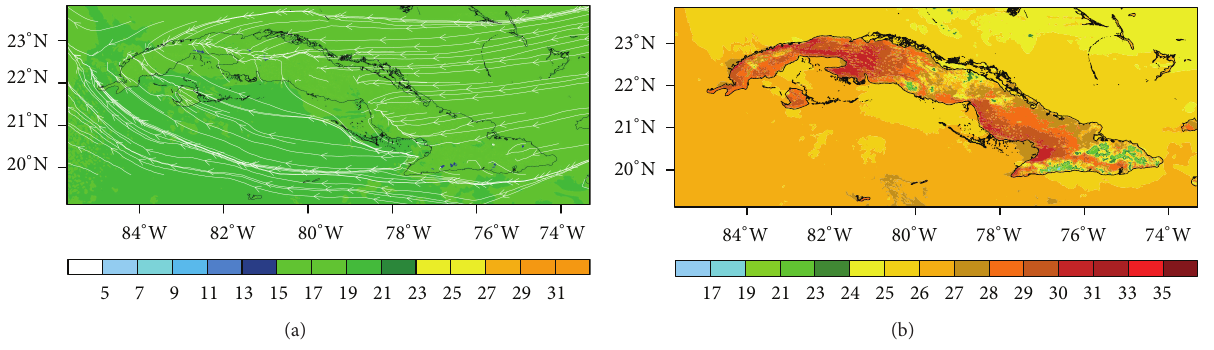
Figure 5: Surface (2m) WRF simulation for 1 May 2012. (a) Water vapor mixing ratio (g/kg) and wind stream lines valid at 1900 UTC. (b) Temperature (degree Celsius) valid at